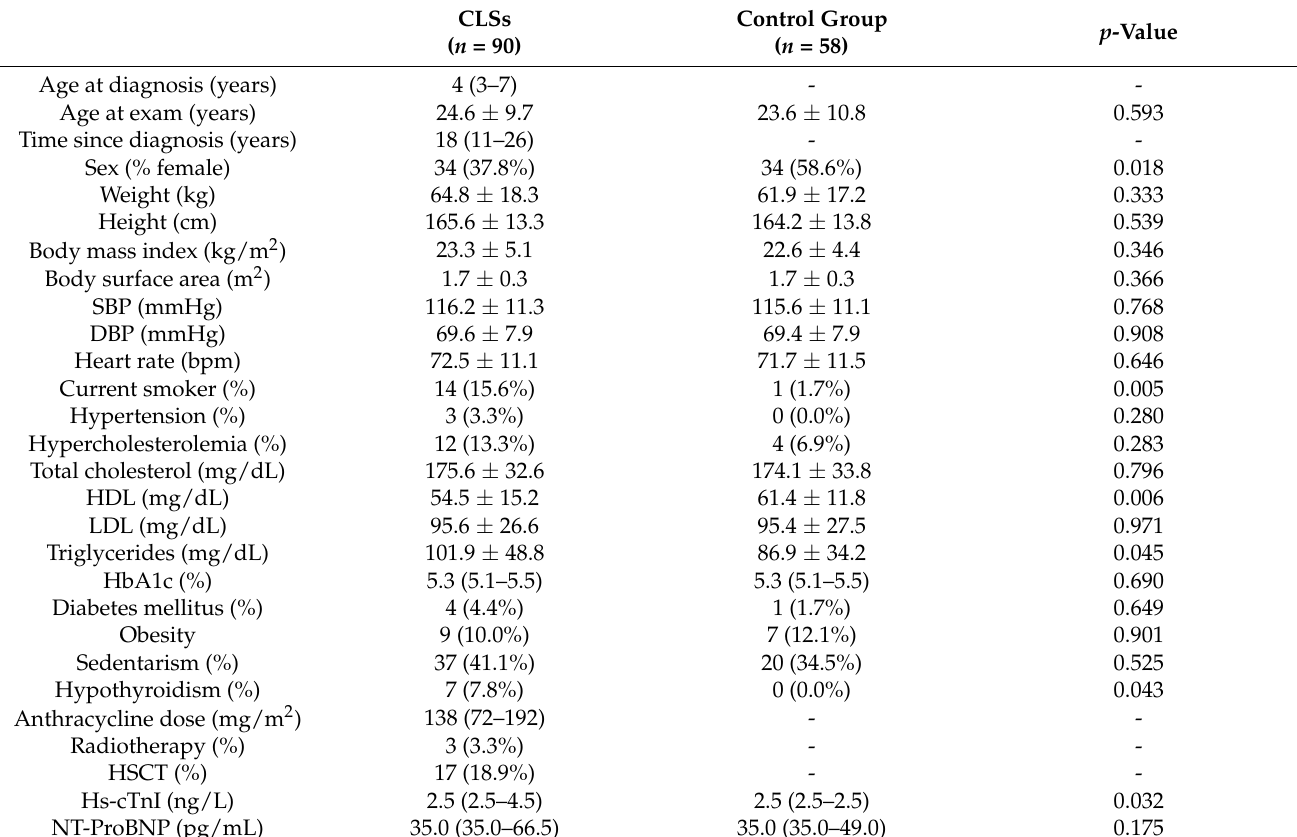
Table 1. Characteristics of childhood leukemia survivors and